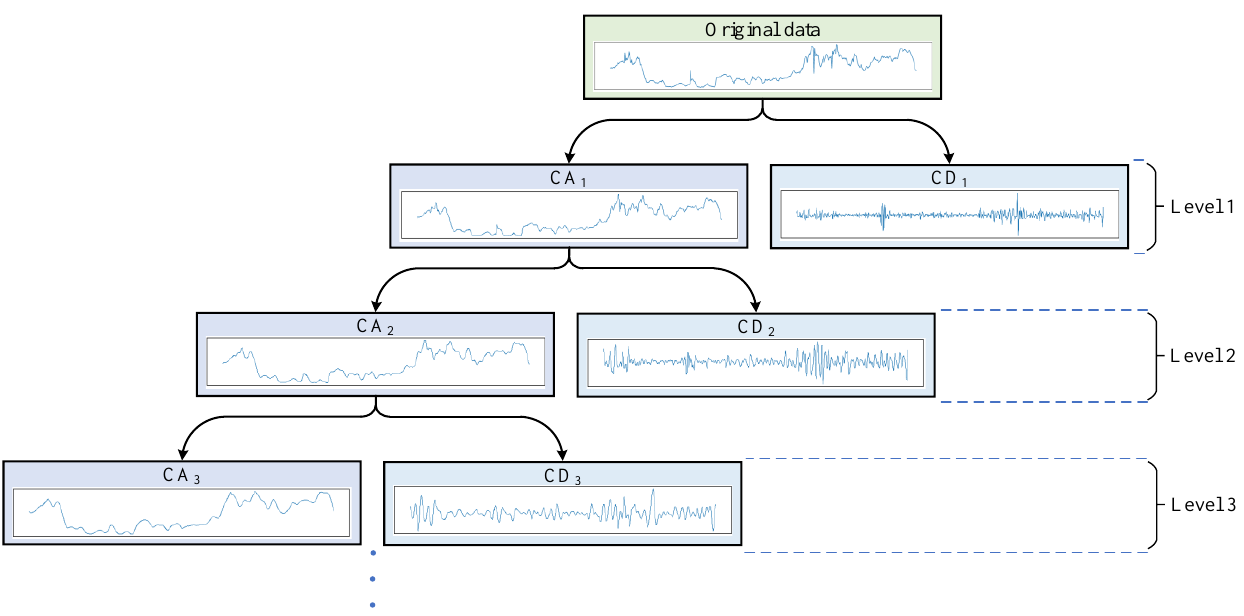
Figure 6. Frequency separator.